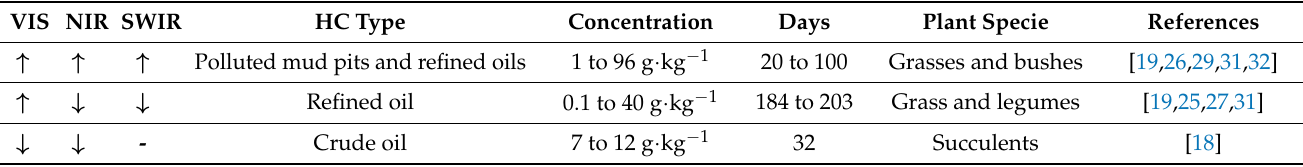
Table 1. Previously published changes in the visible (VIS), near-infrared (NIR), and shortwave infrared (SWIR) reflectance of vegetation depending on the hydrocarbon type, concentration, plant species, and days of exposure. (HC: hydrocarbon, ↑ : increase of reflectance, ↓ : decrease of